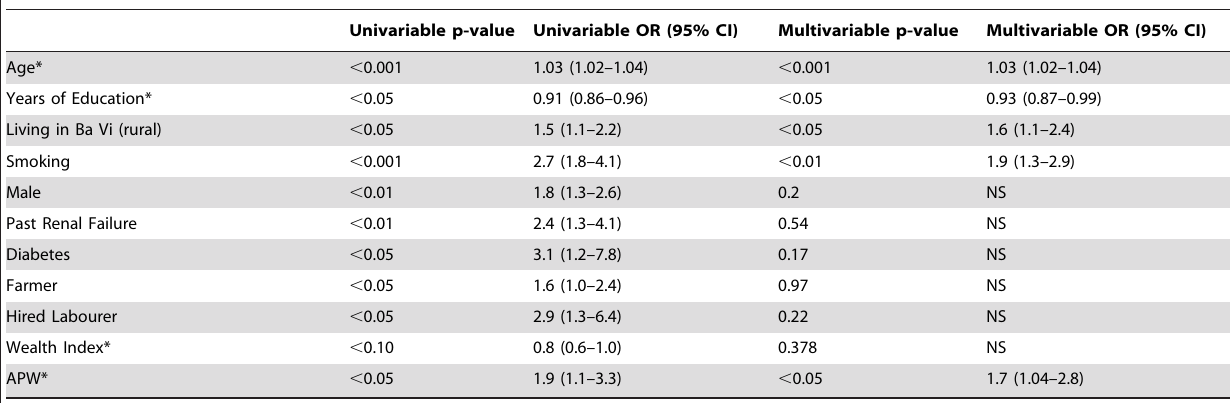
Table 2. Univariable and multivariable odds ratios for K. pneumoniae carriage of several variables.